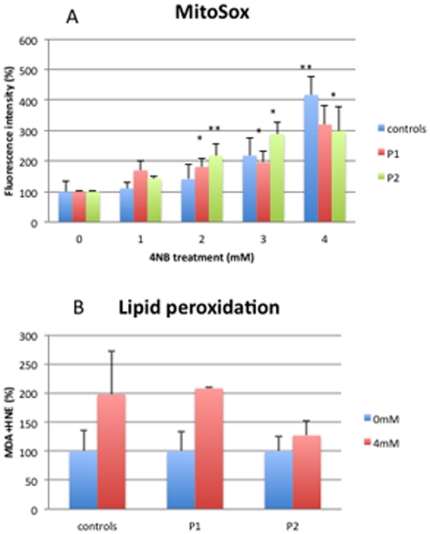
Quantitation of MitoSox staining by flow cytometry (panel A) and oxidation of lipids (panel B) in control (n = 5), P1 and P2 skin fibroblasts after 4-NB treatment.The values are expressed as percentage of controls, P1 and P2 after 4 mM DMSO treatment. (***P<0.001 vs. controls).